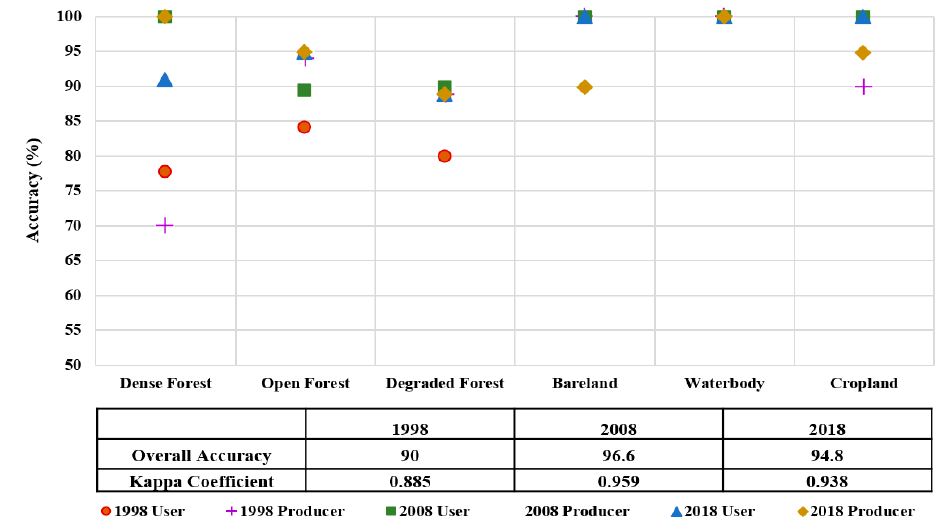
Figure 4. Accuracy assessment for random forest classification for the year 1998, 2008, and 2018.